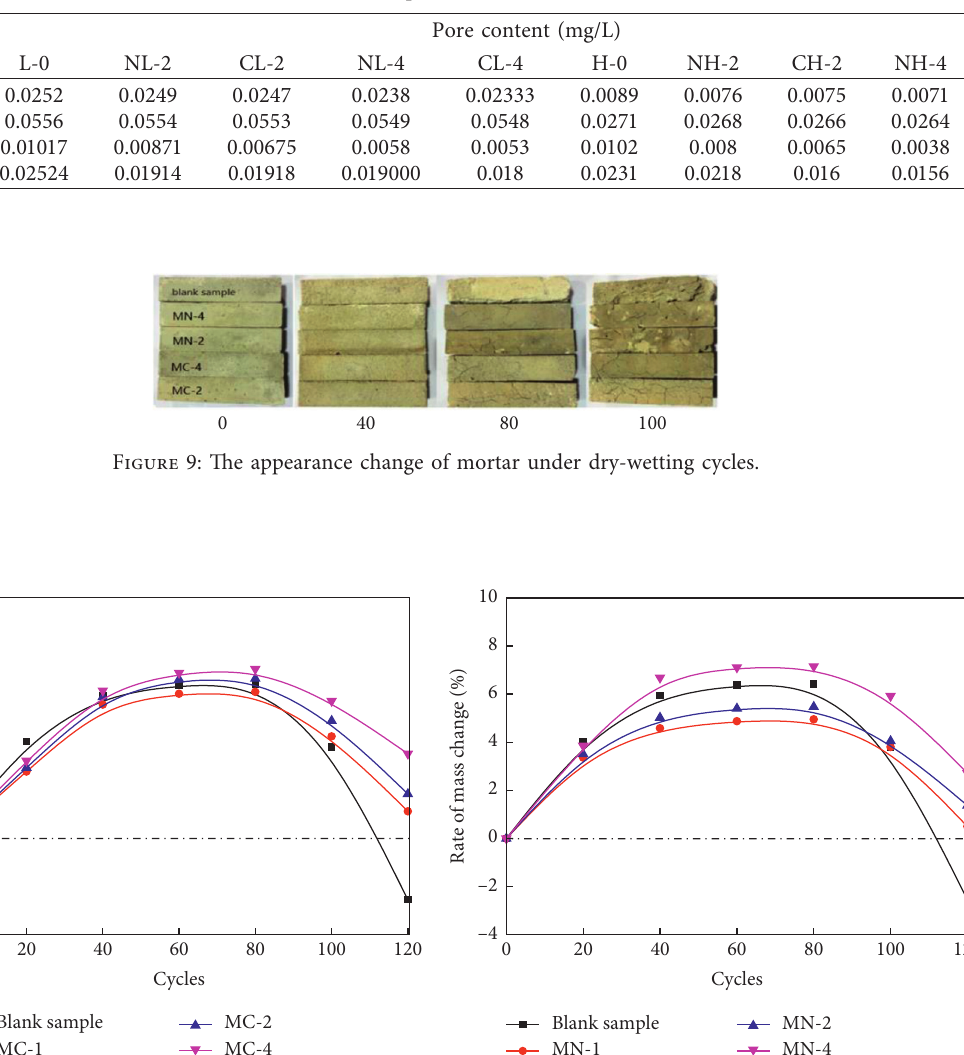
Table 7: The 28d pore content of concrete.